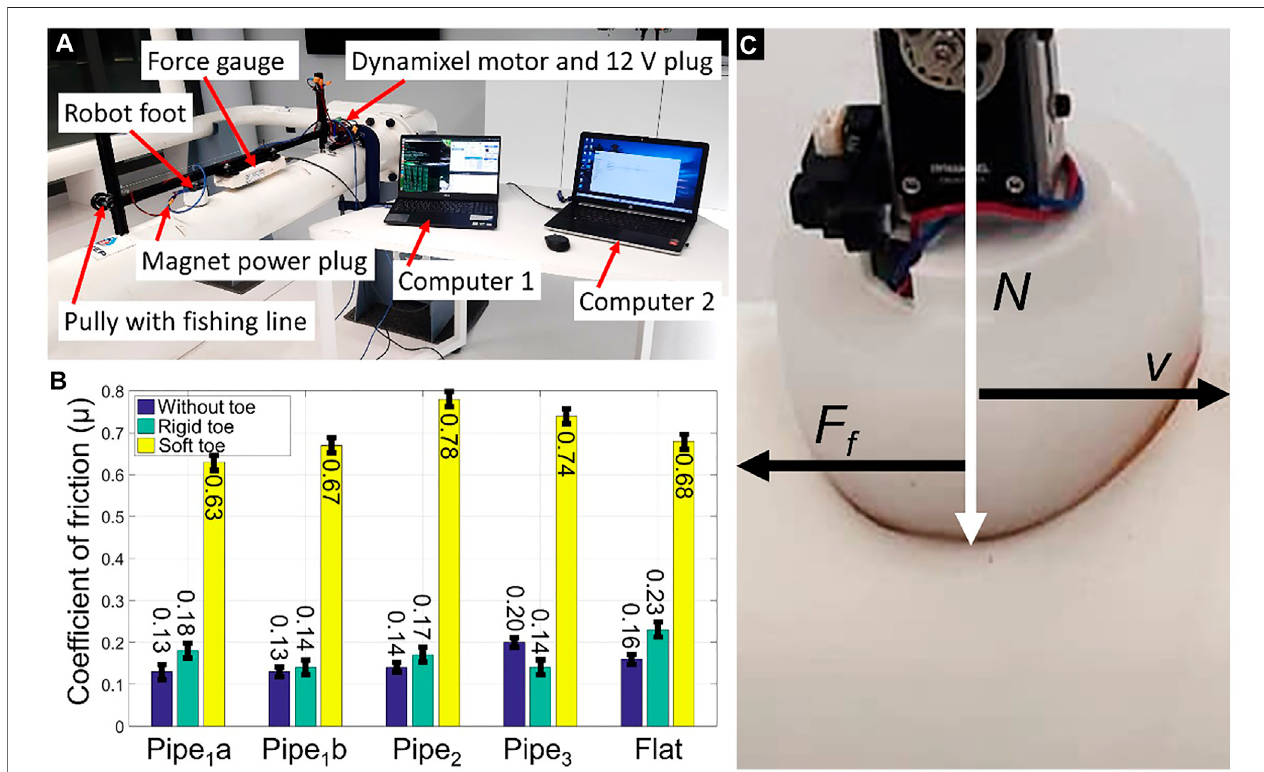
FIGURE 9 | (A) The experimental setup for measuring the friction coef fi cient associated with all tested foot designs. A force gage was attached to the robot foot mounted on an aluminum frame. The robot foot was then moved along the different metal surfaces. The magnet was switched to ON to avoid the magnetic force impacting the measurements. Two separate computers controlled the movement of the Dynamixel motor and recorded the force data, respectively. (B) The friction coef fi cient of the robot foot under various test conditions. Pipes 1 a,b represent the metal pipes without and with painted surfaces, each with a diameter of 16 cm. Pipes 2,3 measured 22 and 60 cm in diameter, respectively. The tests were repeated 10 times for each tested surface and all robot-foot designs. (C) The robot feet pushing on the metal pipe with normal load N resulting in a friction force F f , while stroking it with velocity